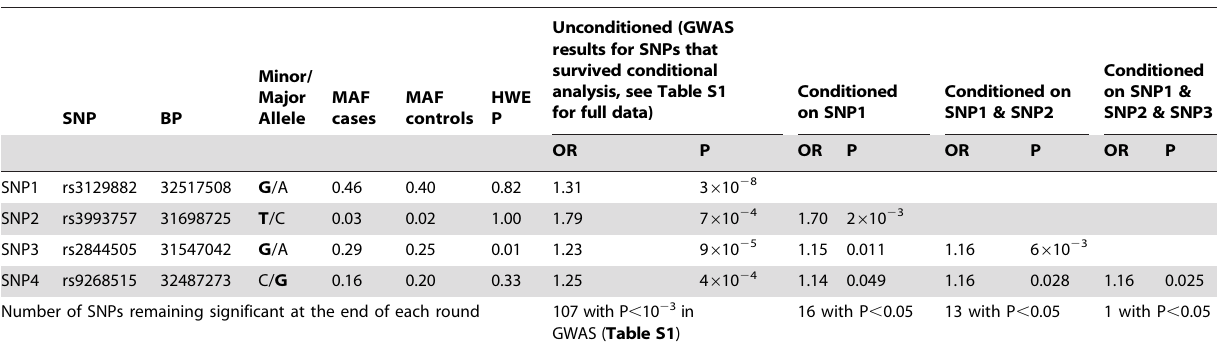
Table 2. Step-wise conditional